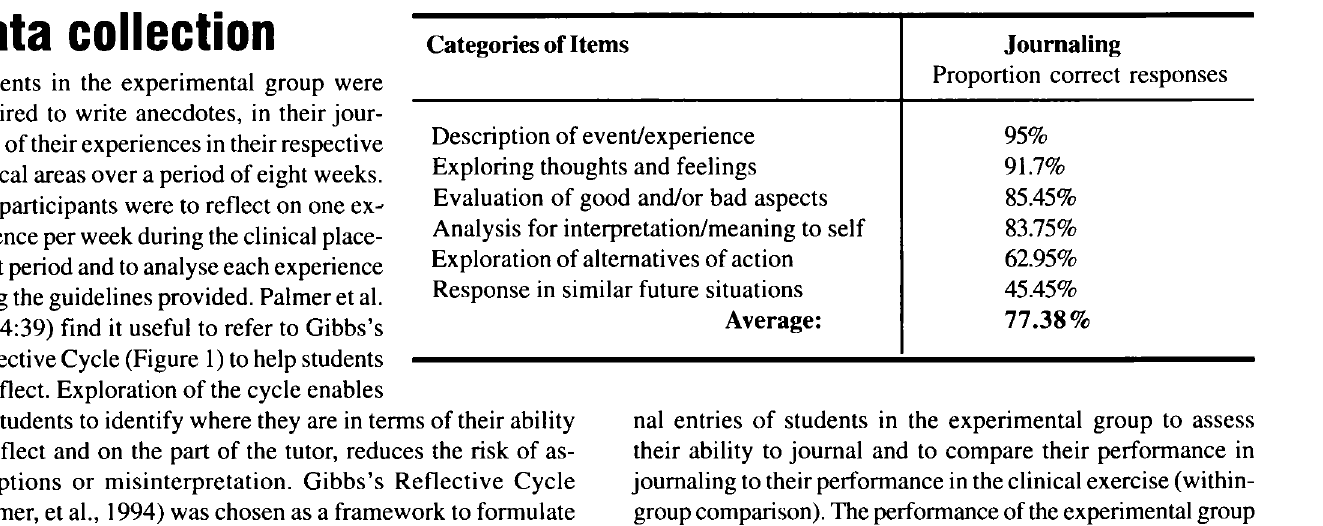
Table 1 : Experimental Group: Ability to Journal (n=20)